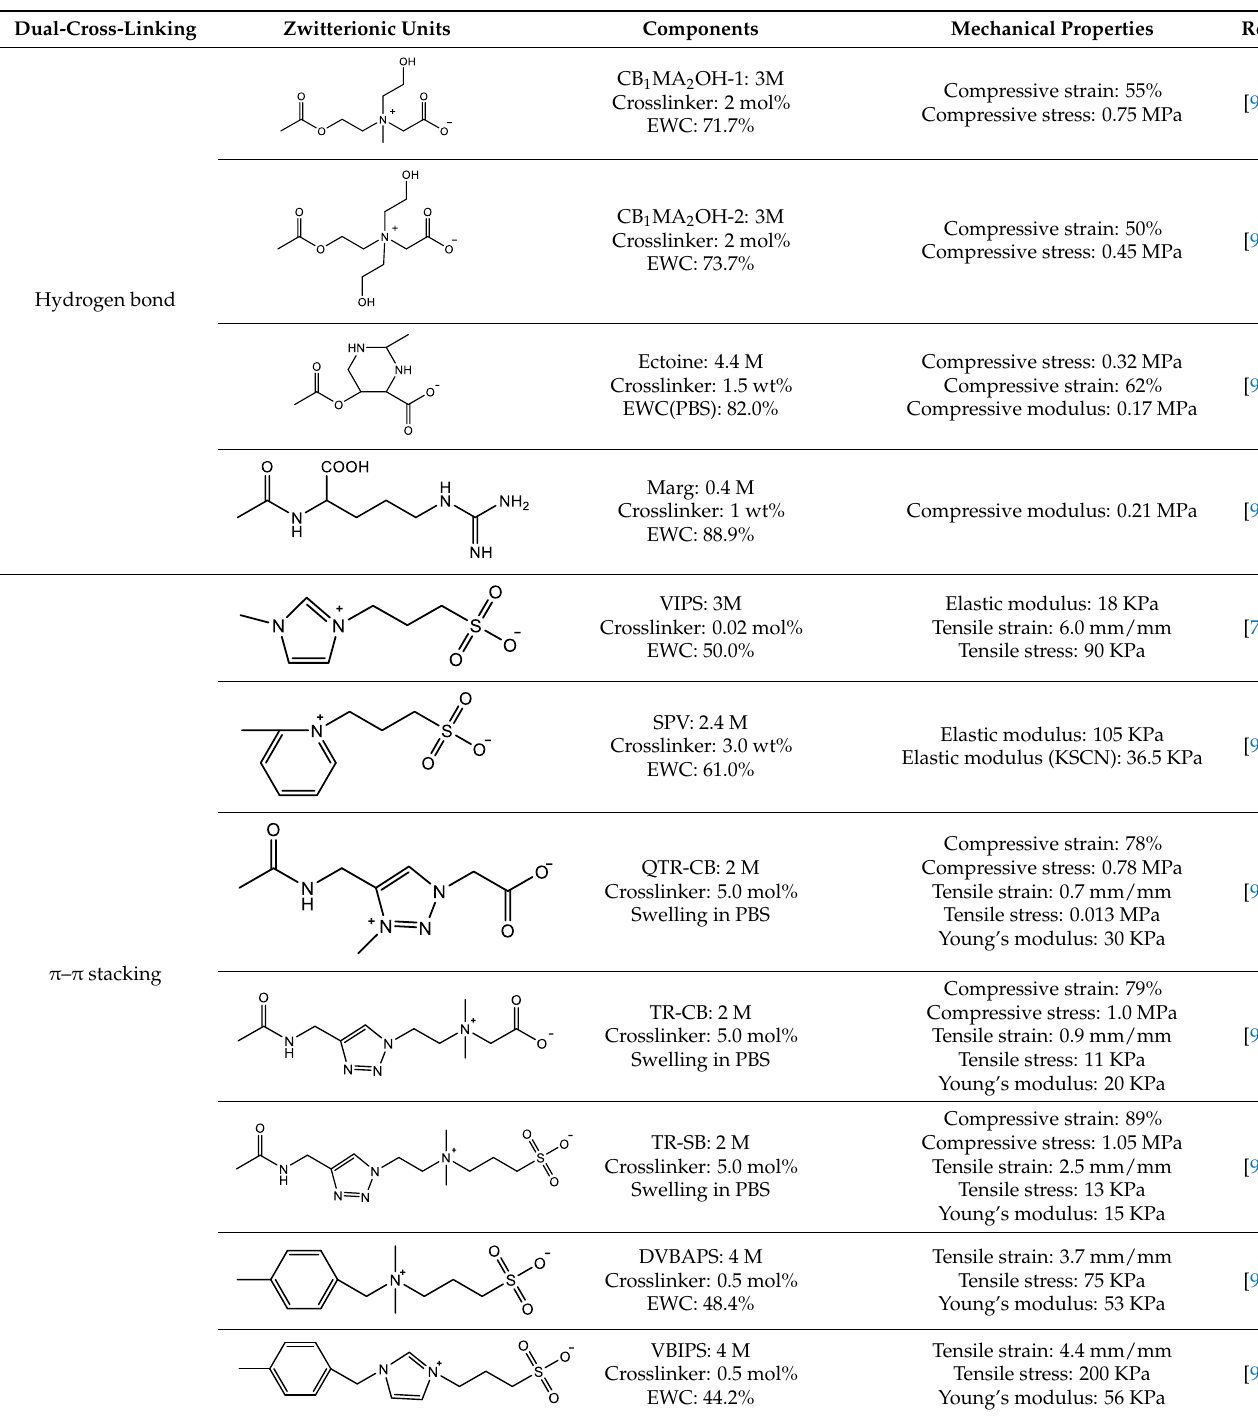
Table 2. Molecular design of zwitterionic hydrogels and their mechanical properties.